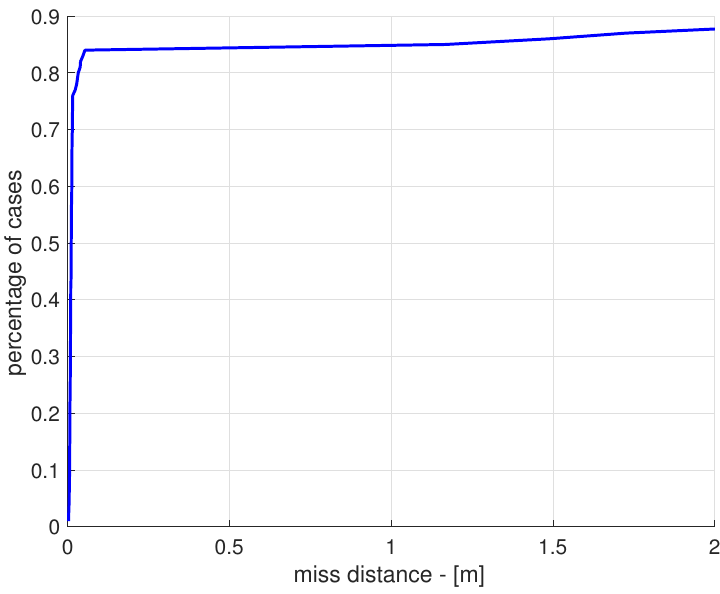
Figure 4. Miss distance cumulative distribution obtained in the simulation